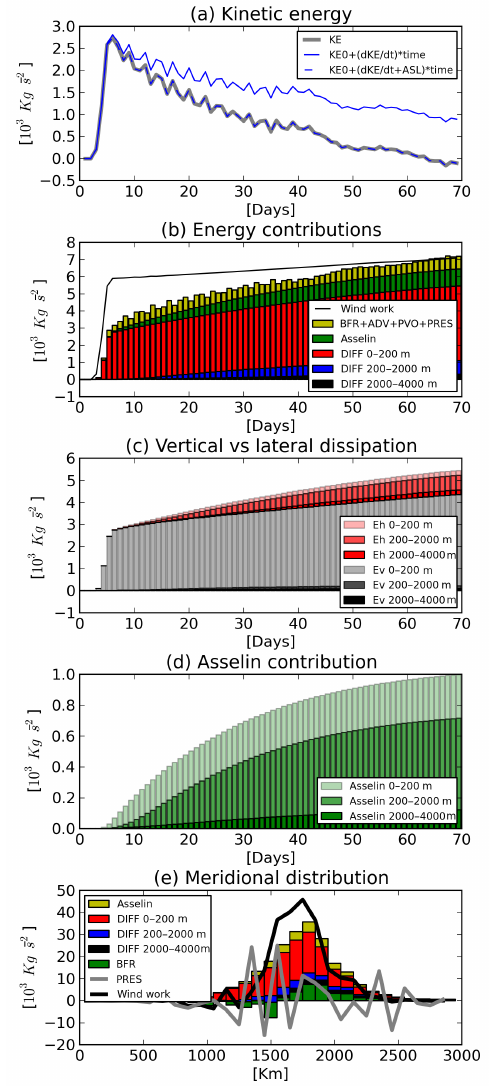
Figure 10. Domain-averaged response of the ocean to the passage of a storm from the same experiment already described in Figs. 5, 8 and 9. In order to isolate the response of the storm, we show here the differences with a reference experiment without storm and starting from exactly the same initial conditions. (a) Horizontal kinetic en- ergy (m 2 s − 2 ) computed directly from model velocity (bold black) and indirectly from the time integral of kinetic energy tendency computed online before (red) and after (dotted red) Asselin time fil- tering. (b) Cumulated contribution of the different terms of the KE equation (DIFF represent the sum of both horizontal and vertical dissipations). (c) Cumulated lateral ( E h ) and vertical ( E v ) energy dissipation integrated in different depth ranges. (d) Cumulated dis- sipation of energy by the Asselin time filter integrated in different depth ranges. (e) Meridional distribution of cumulative wind work, viscous dissipation, bottom friction, horizontal pressure gradients and Asselin energy dissipation at day